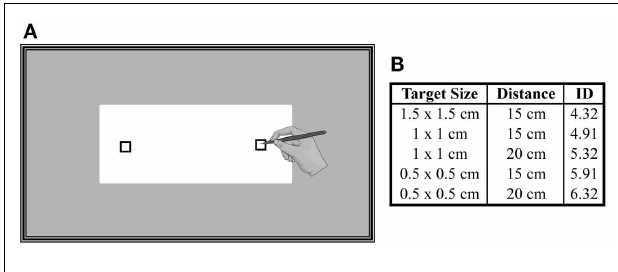
FIGURE 1 | (A) Schematic representation of the experimental setup. A sheet of paper (A4 format) was placed on a table and participants had to actually point or to imagine pointing between the targets as accurate and as fast as possible. (B) Three different sizes of targets and two inter-target distances were used to modulate the difficulty of the task